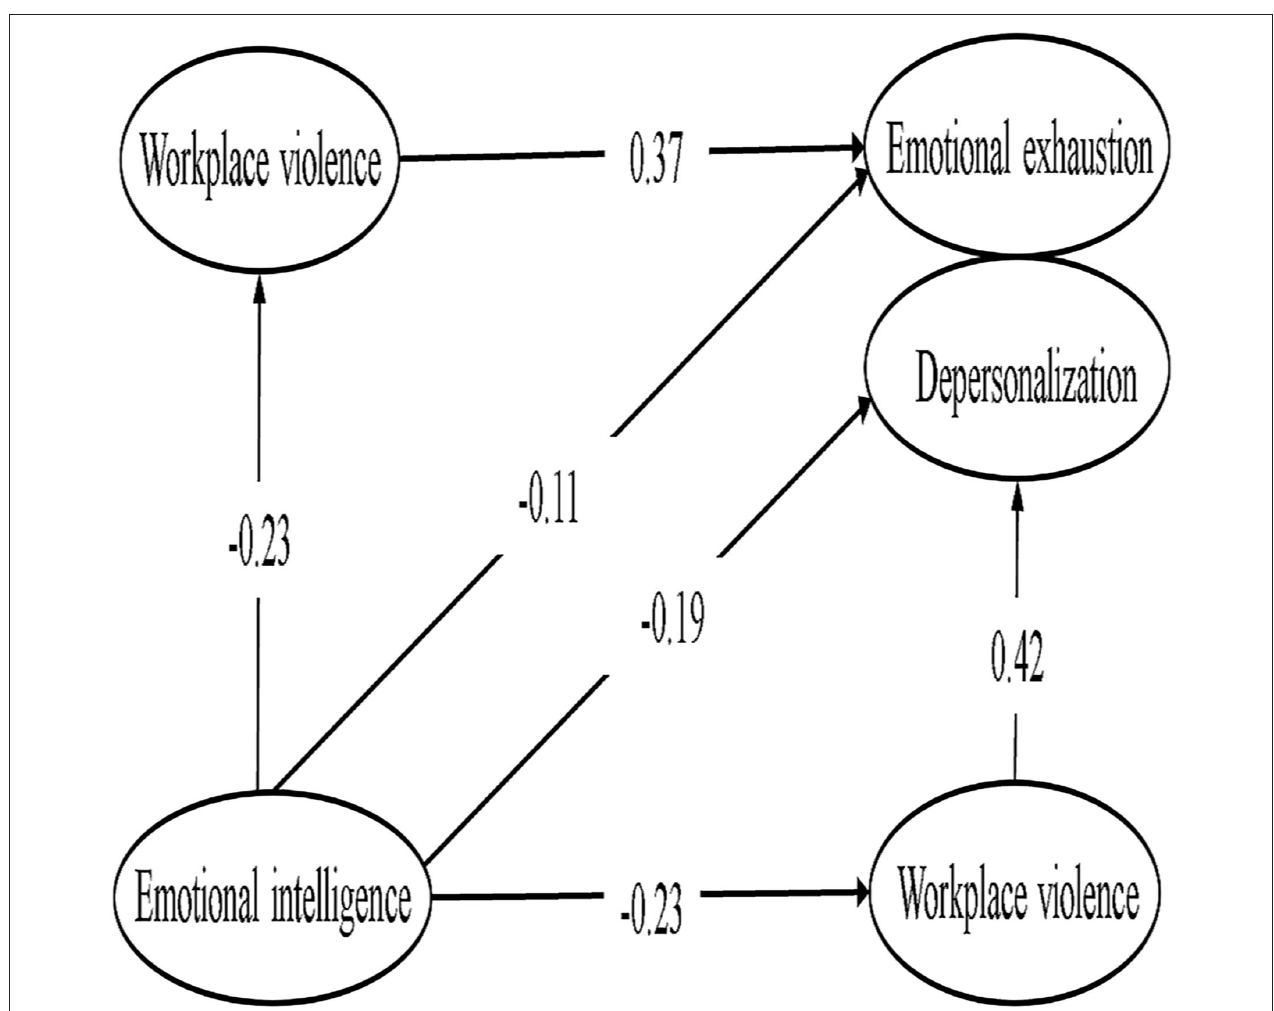
FIGURE 1 | Workplace violence play a mediating role between Emotional intelligence and Emotional exhaustion,